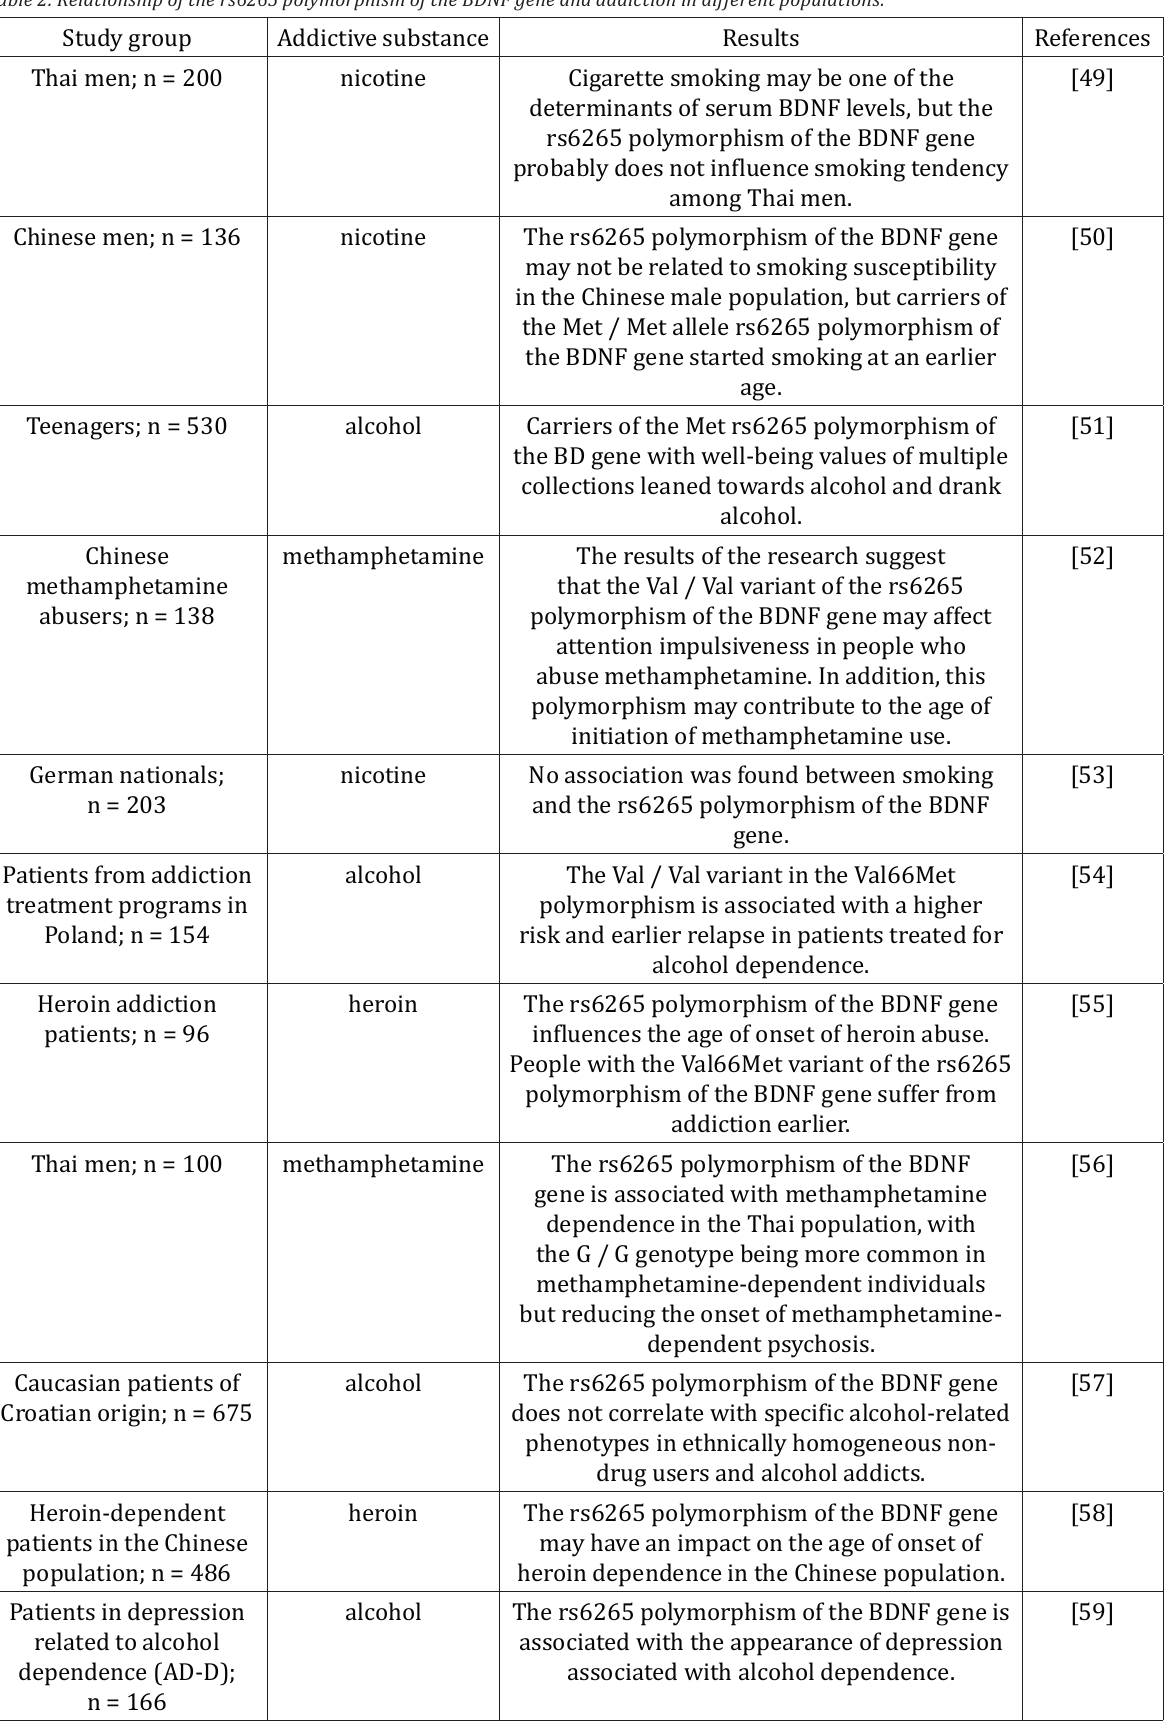
Table 2. Relationship of the rs6265 polymorphism of the BDNF gene and addiction in different populations.